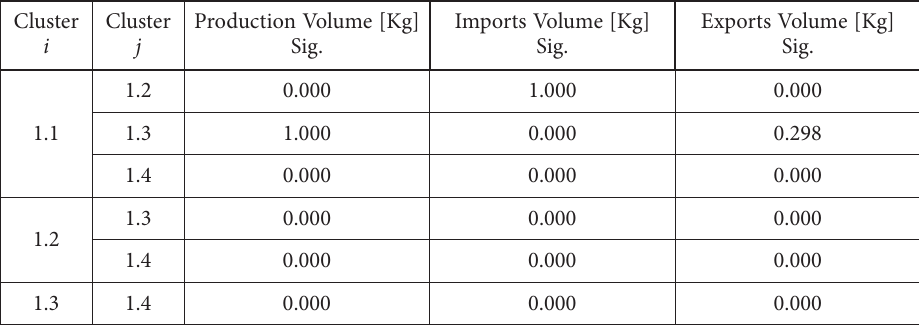
Table 6. Multiple comparisons (Bonferroni) at the second level of pre-crisis clustering (source: own elaboration based on COMTRADE, 2018) Cluster Cluster i j